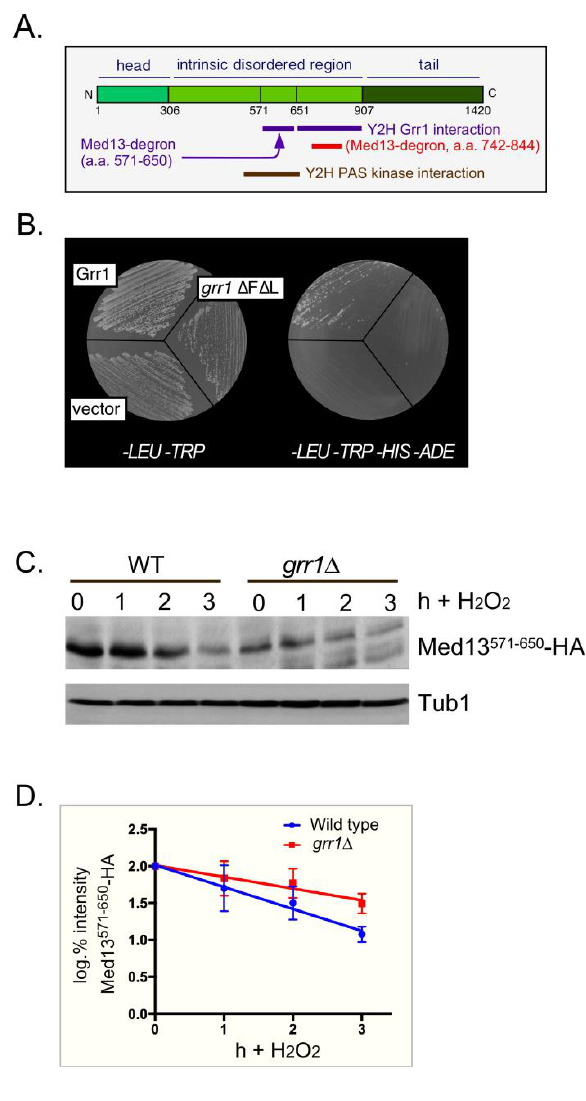
FIGURE 2: Med13 contains two H 2 O 2 stress responsive degrons. (A) Cartoon of the results from ProteinPredict® [89] analysis of yeast Med13. The amino and carboxyl terminal domains are struc- tured and separated by a large intrinsic disordered region. The positions of the two degrons are indicated. (B) Yeast two hybrid analysis of degron 571-650 and Grr1 derivatives. Yeast PJ69-4a cells harboring Med13-activating domain plasmid (pDS15) and either pAS2, pAS-Grr1 or pAS2-Grr1∆F∆L binding domain plasmids were grown on -LEU, -TRP drop out medium to select for both plasmids (left panel) and -TRP, -LEU, -HIS –ADE (right panel) to test for Med13-Grr1 interaction. (C) Wild-type (RSY10) or grr1 ∆ cells (RSY1770) harboring degron 571-650 (pDS15) were treated with 0.4 mM H 2 O 2 for the timepoints indicated and Med13 571-650 -HA levels analyzed by Western blot. Tub1 levels were used as loading con- trols. (D) Degradation kinetics of the degron 571-650 constructs shown in C. Values represent averages ± SD from a total of at least two Western blots from two independent